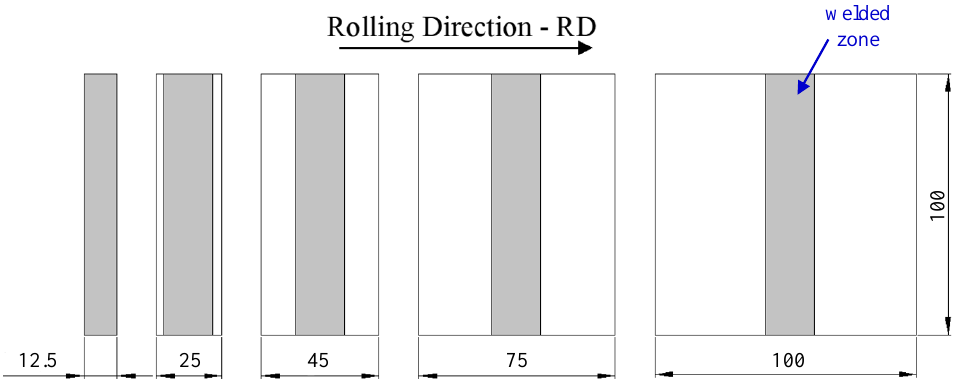
d shoulder =12 mm pin angle = 30° pin